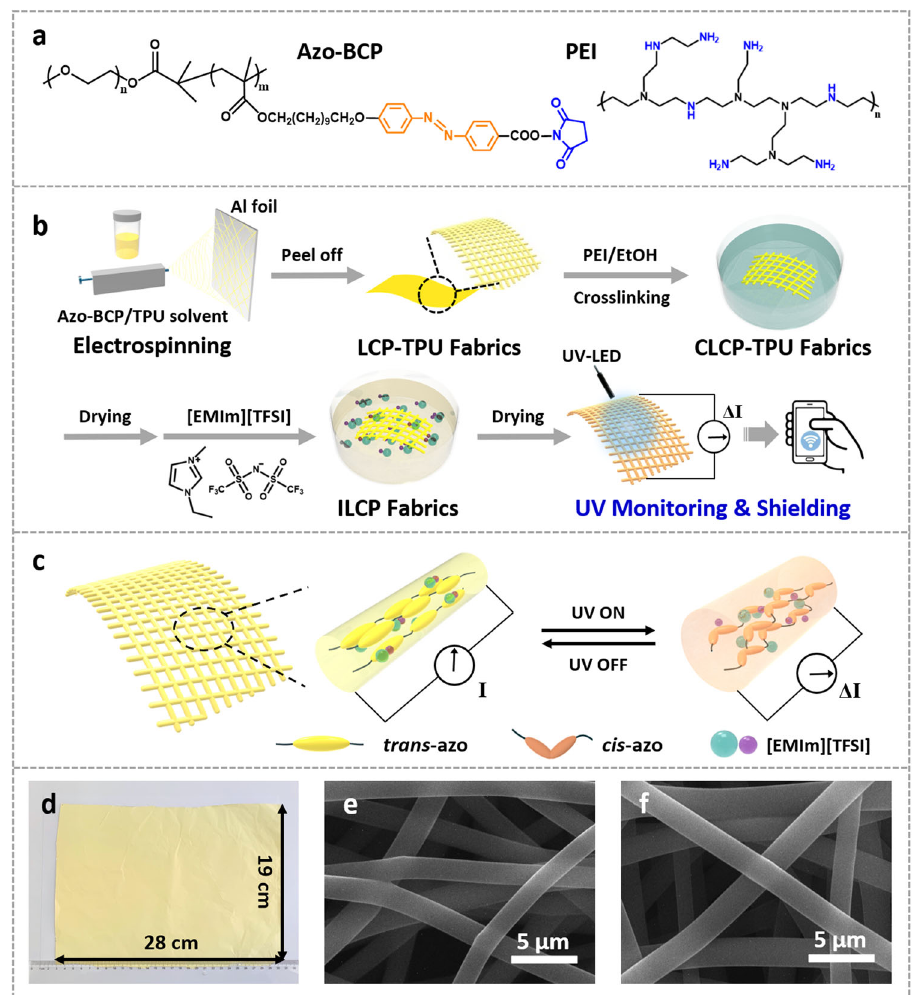
Fig. 1 Fabrication of ILCP fabrics. a Chemical structures of the Azo-BCP and PEI used in this study. b Experimental schematic illustration of the fabrication process of ILCP fabrics. c Schematic illustration of the structure and mechanism for the ILCP-based device. d The photograph of as-fabricated large-scale LCP-TPU fabrics with a size of 28 cm × 19 cm × 20 μ m. SEM images of e CLCP-TPU fi bers and f ICLP fi